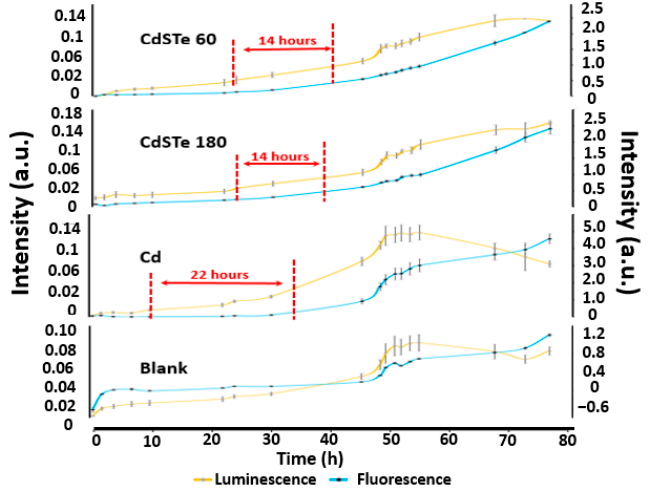
Figure 5. Luminescence and fluorescence indicate apoptosis and necrosis of HEP-G2 cells exposed to CdSTe QDs (synthesized at 60 and 180 °C at 2.0 mg/L) and cadmium solution at 2.0 mg/L. Fluorescence was recorded using 485 nm excitation and 525–530 nm emission.